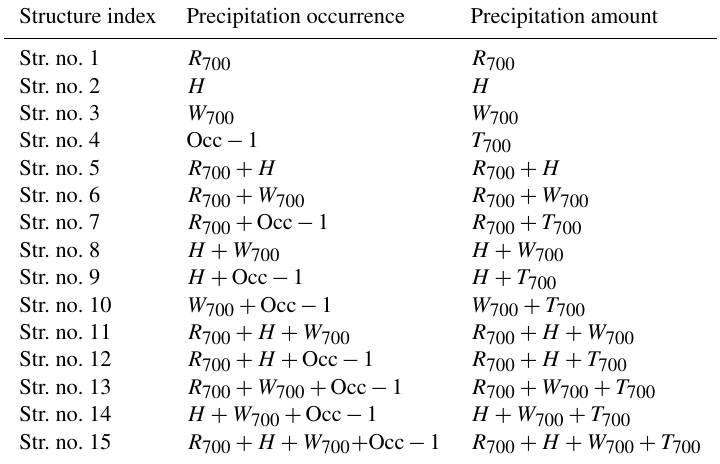
Table 2. Possible regressive structures (i.e., a combination of predictors) for the modeling of precipitation occurrence and amount. Structure index Precipitation occurrence Precipitation amount Str. no.